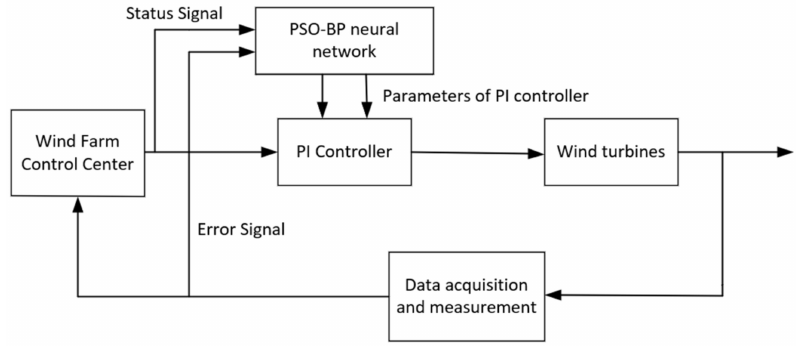
Figure 2. IPSO-BP-PI controller of the power